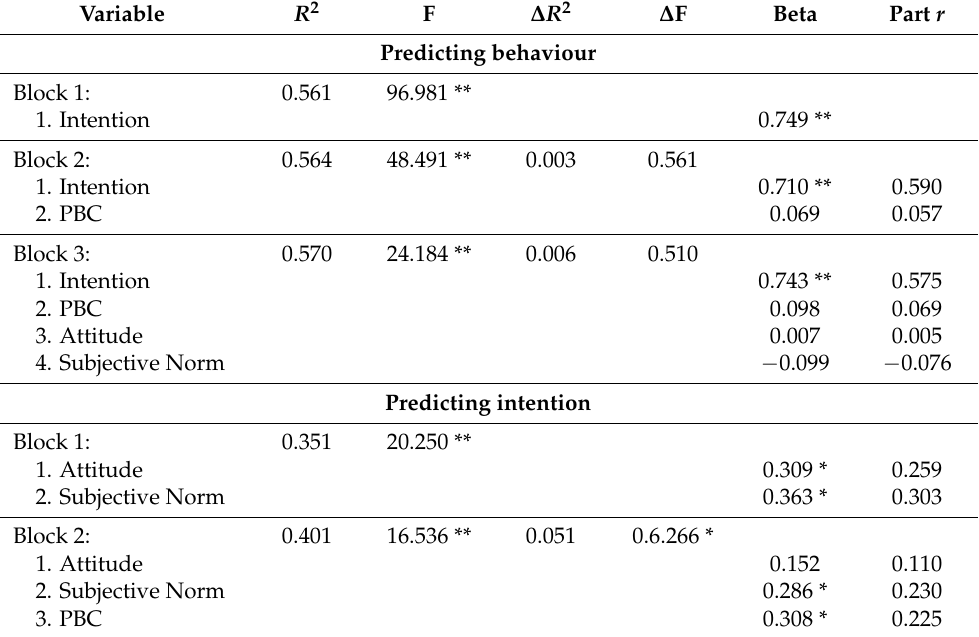
Table 7. HRA for the original